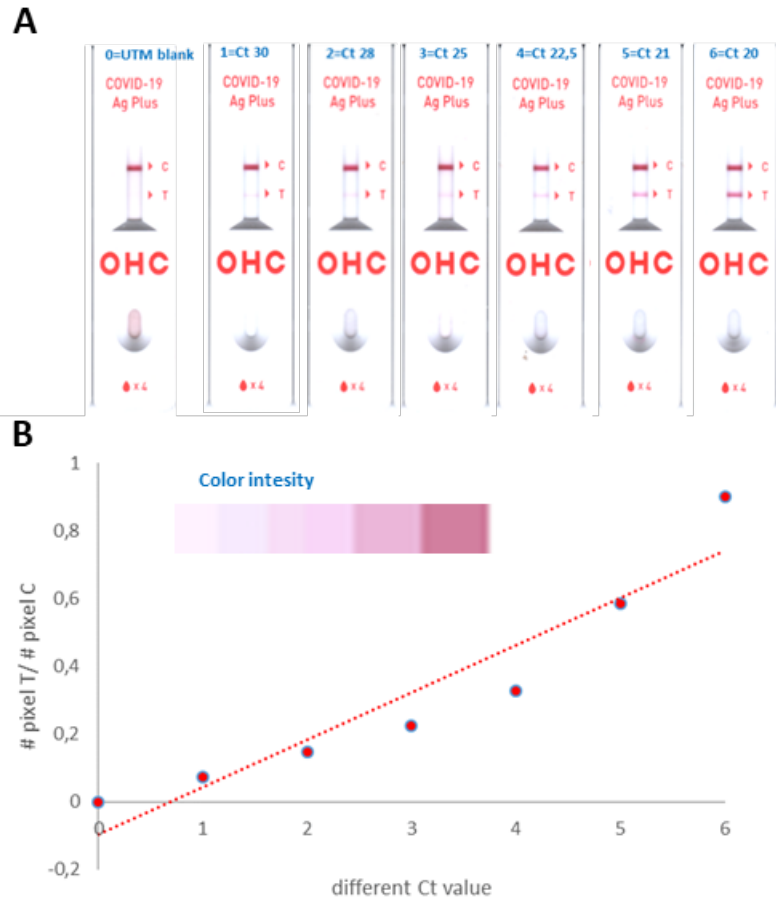
Figure 1. ( A ) RAT test with different Ct values and ( B ) COI index. Table 4. Variant of Concern tested on GeneFinder COVID-19 Ag Plus Rapid